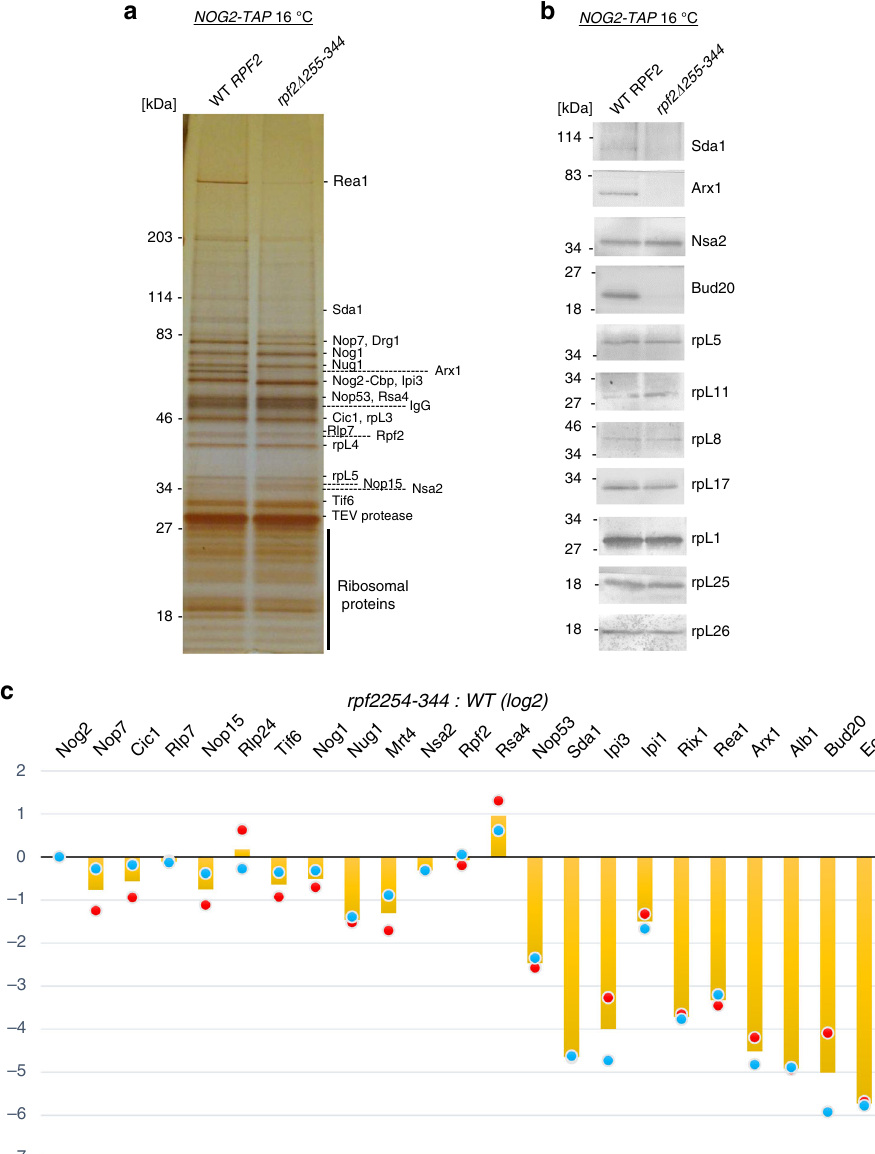
Fig. 2 AFs necessary for 5S rotation and export are affected in the rpf2 Δ 255-344 mutant. a SDS-PAGE of proteins in assembling 60S subunits from wild- type cells or from the rpf2 Δ 255-344 mutant shifted to 16 °C for 5 h. Pre-ribosomal particles were puri fi ed using AF Nog2 as a bait and protein constituents were separated by electrophoresis and stained with silver. Molecular weight standards, the Nog2 bait protein Nog2-Cbp (calmodulin-binding peptide left behind after TEV cleavage), and relevant AFs are labeled. b Samples from a were subjected to western blotting using antibodies against speci fi c proteins. All samples were derived from the same experiment and western blottings were processed in parallel. c Samples prepared as described in a were used for iTRAQ (semi-quantitative mass spectrometry) to quantify relative changes in levels of AFs in the genomic rpf2 Δ 255-344 mutant compared with the wild- type strain. The ratios were normalized to levels of Nog2 (bait). The fold change is shown using bar graphs (orange) in log2 scale as an average of two biologically independent samples ( n = 2) for the genomic rpf2 Δ 255-344 mutant compared with the wild-type grown at 16 °C. Dot blots represent values for each biological replicate (red and blue). Source data are provided as a Source Data fi